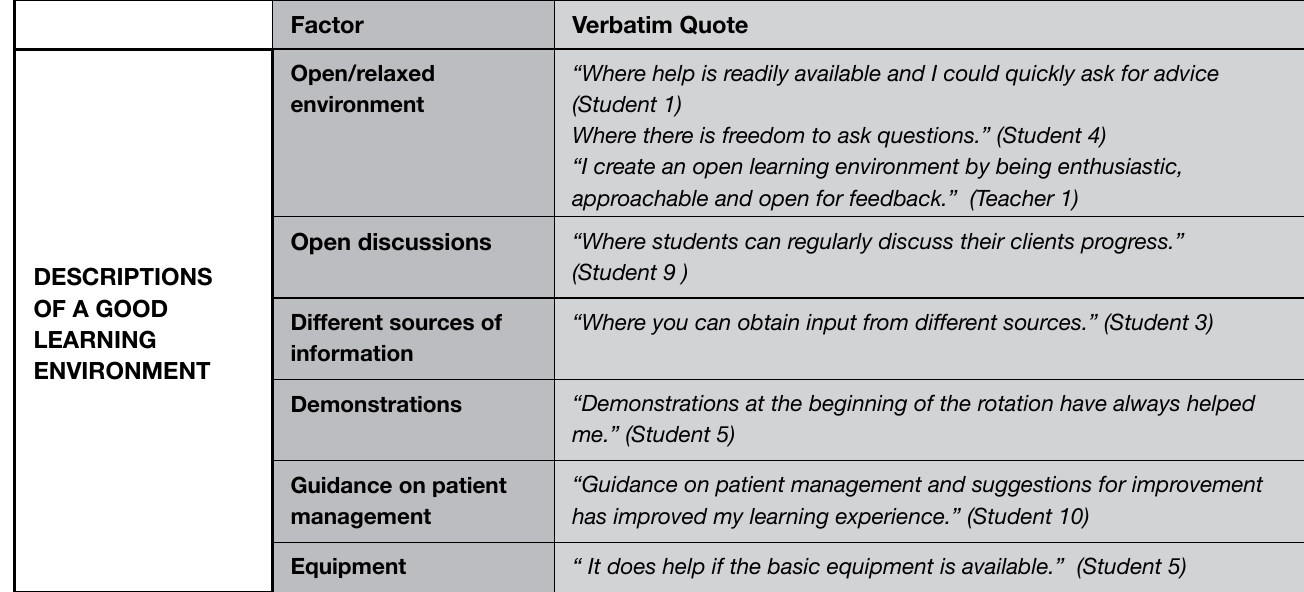
Table 3: Summary of factors involved in creating an optimal learning environment